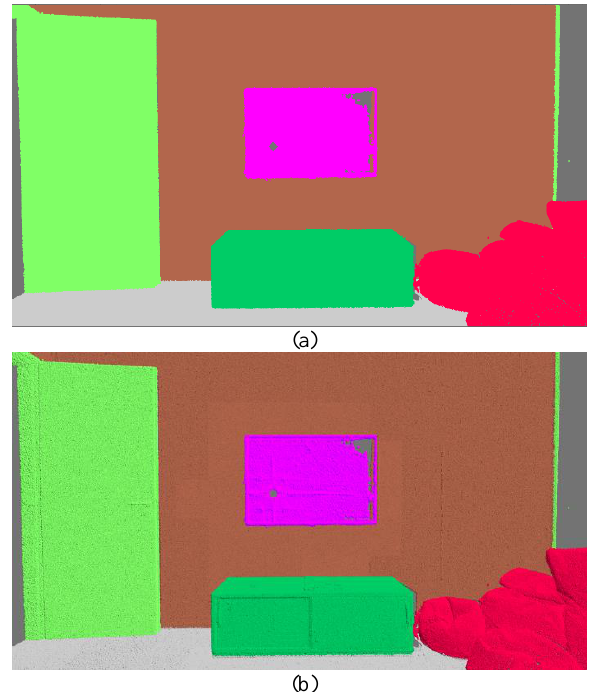
Figure 7. Classified point cloud rendered;(a) before and after(b) application of the implemented